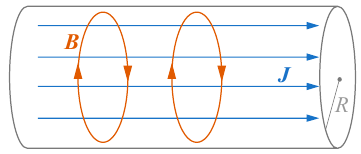
Figure 1. Piston rod with injected current.